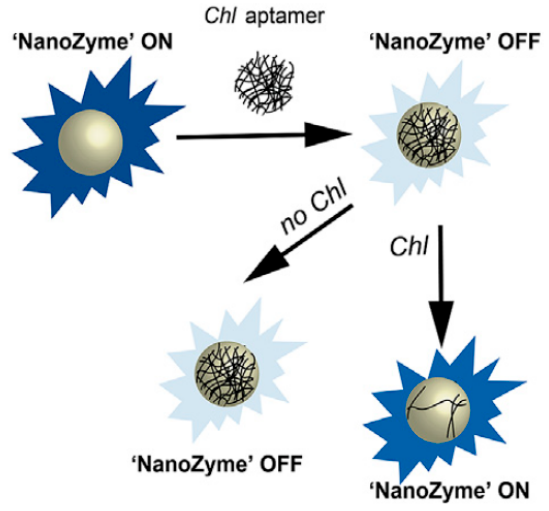
Figure 14. Working principle of tyrosine-capped silver nanoparticles used for the detection of chlorpyrifos (Chl). (Reprinted with permission from [147]. Copyright © 2019, Elsevier B.V. All chlorpyrifos (Chl). (Reprinted with permission from [147] . Copyright © 2019, Elsevier B.V. All rights rights reserved).